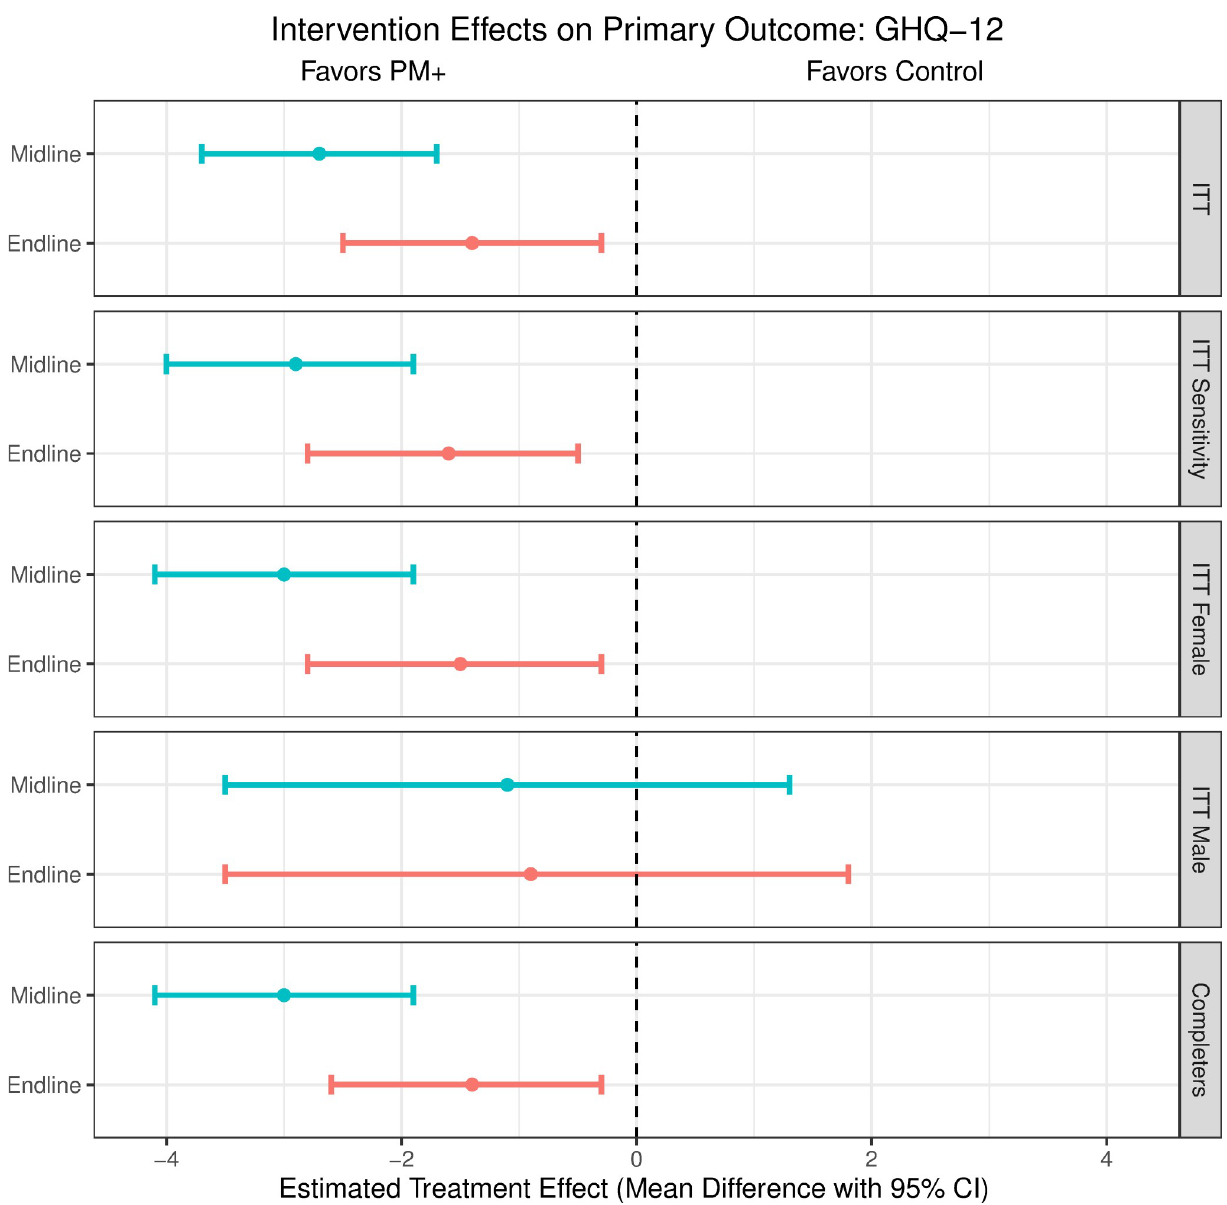
Fig 2. Intervention effects on primary outcome (GHQ-12) at midline (approximately 1 week after treatment) and endline (approximately 3 months after treatment). GHQ-12, General Health Questionnaire; ITT, intention to treat; PM+, Problem Management Plus.